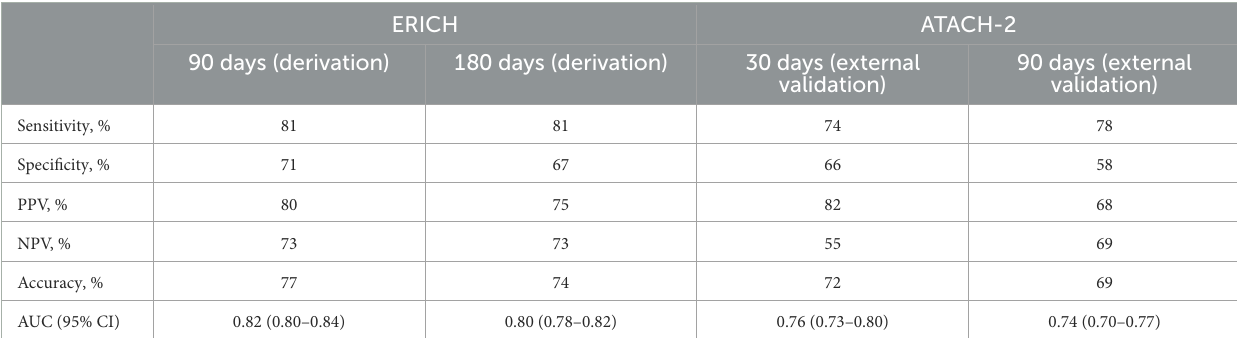
TABLE 6 Discriminative ability of SAVED 2 score ≥ 3 to predict unfavorable outcome (mRS 3–6) in the ERICH (derivation) and ATACH-2 (external validation)